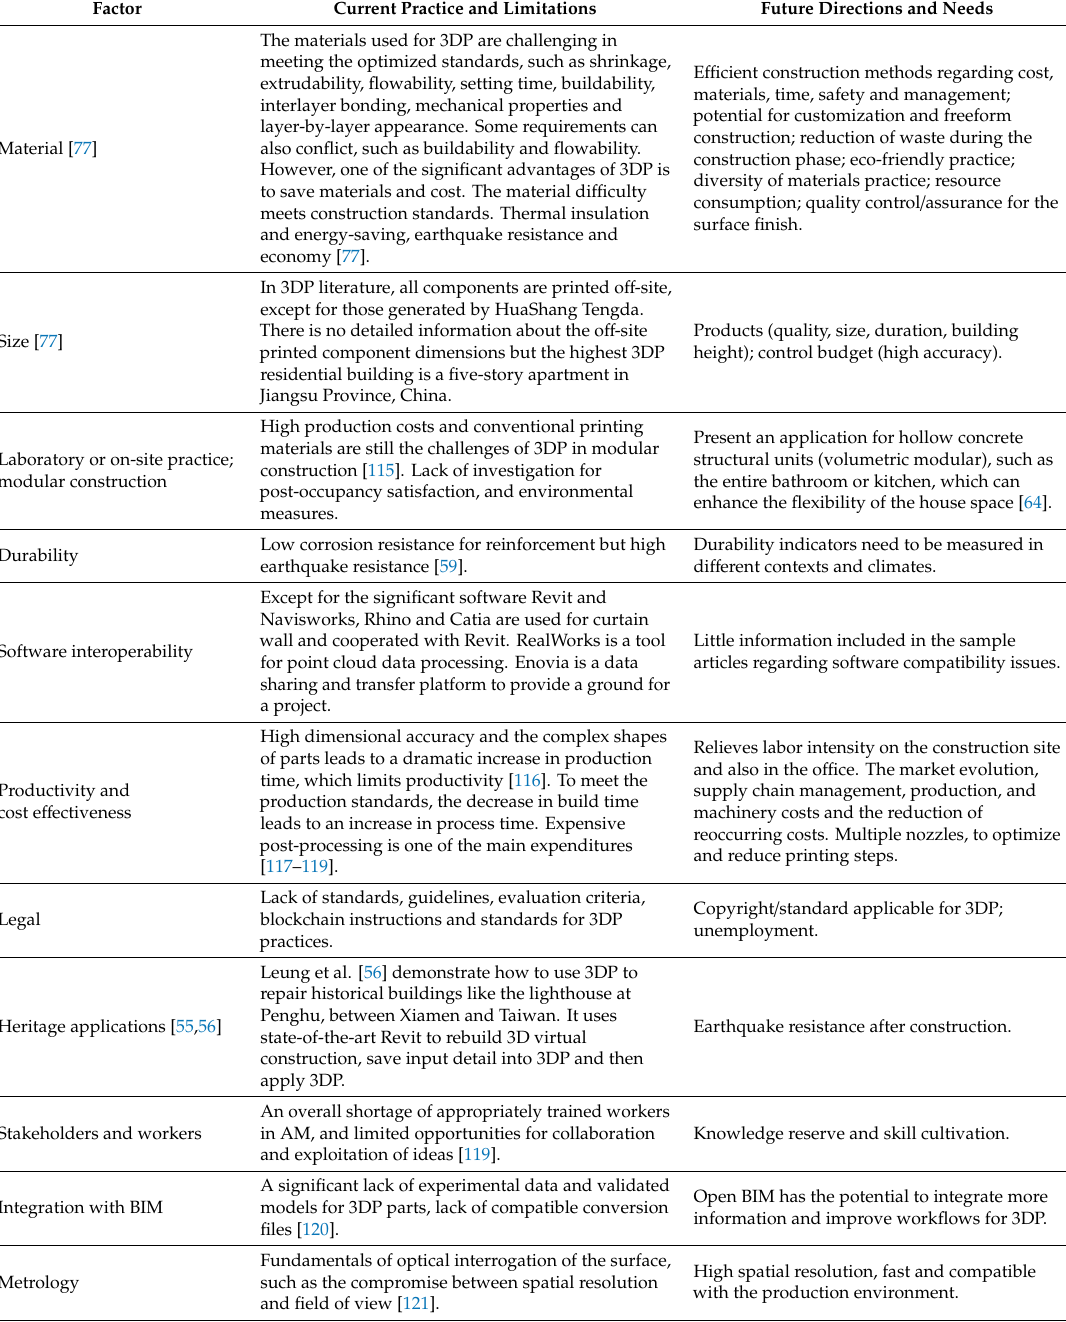
Table 11. A summary of the benefits and limitations experienced in previous practice within 3DP